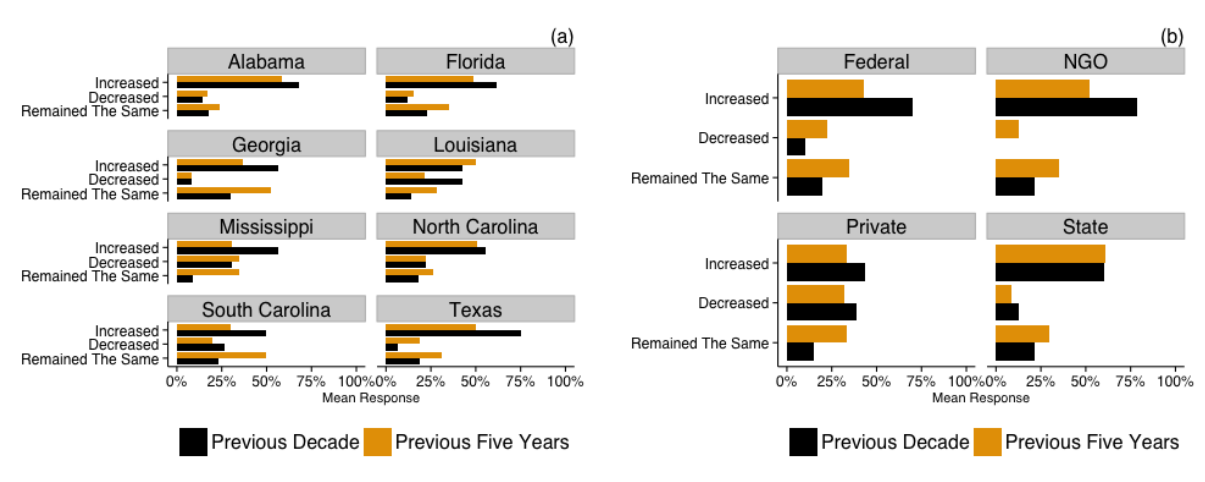
Figure 1. Average response percent for perceived change in prescribed fire use during the previous decade and previous five years by state ( a ) and land management entity/type ( b ).